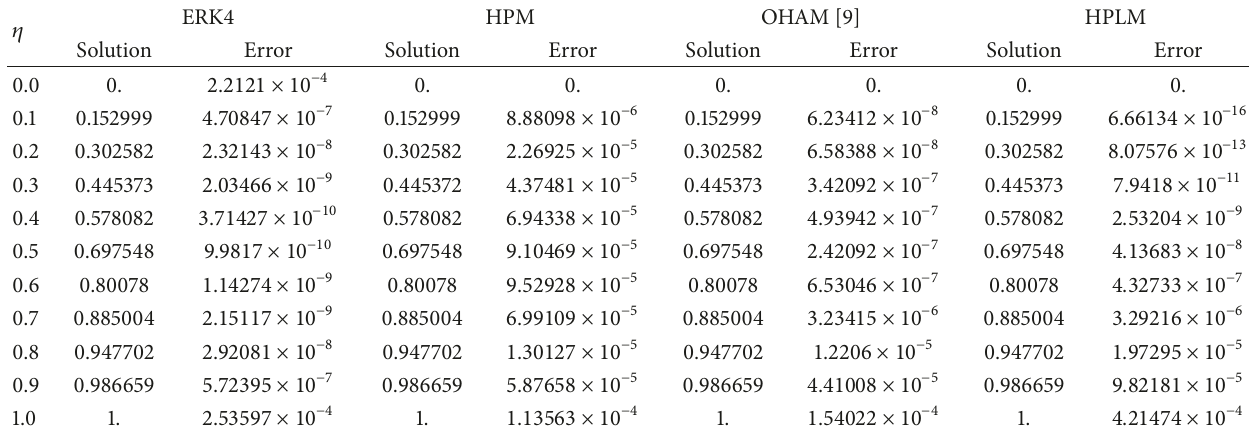
Table 3: Comparison of solutions along with absolute residual errors for various analytical and numerical schemes at 𝑅 = 0.5